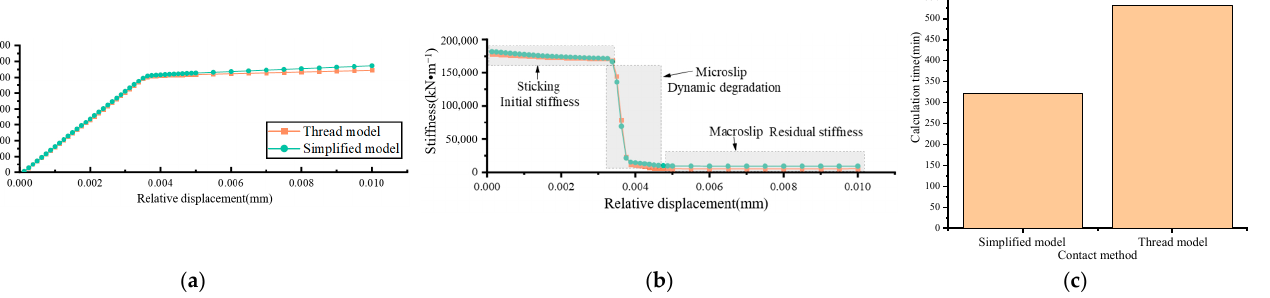
Figure 18. Dynamic degradation of the thread model and simplified model under mixed-mode loading: ( a ) backbone curves, ( b ) stiffness degradation curves, ( c ) calculation time.